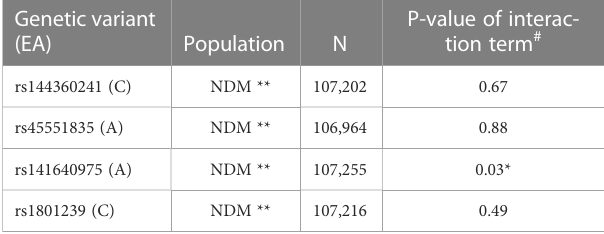
TABLE 5 Interaction with albuminuria in SNV-eGFR creatinine analyses in UKBB (model 1). Genetic variant